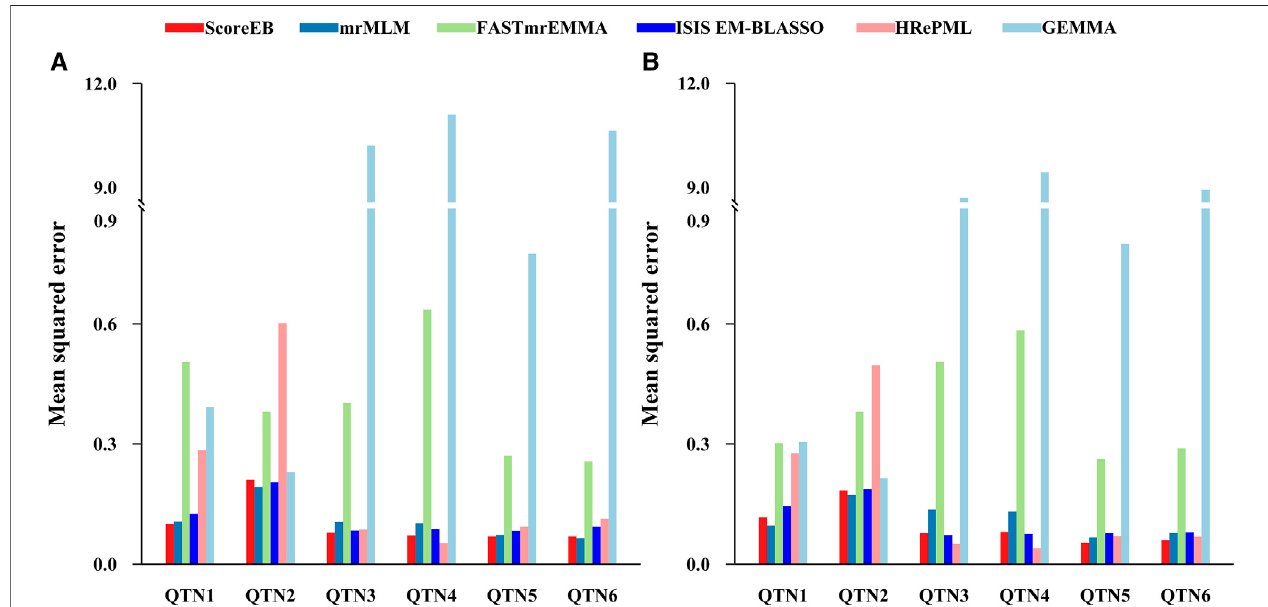
FIGURE 2 | Comparison of mean squared error (MSE) of six simulated QTNs using six methods (ScoreEB, mrMLM, FASTmrEMMA, ISIS EM-BLASSO, HRePML and GEMMA) in simulation 1 (A) and simulation 2 (B) .